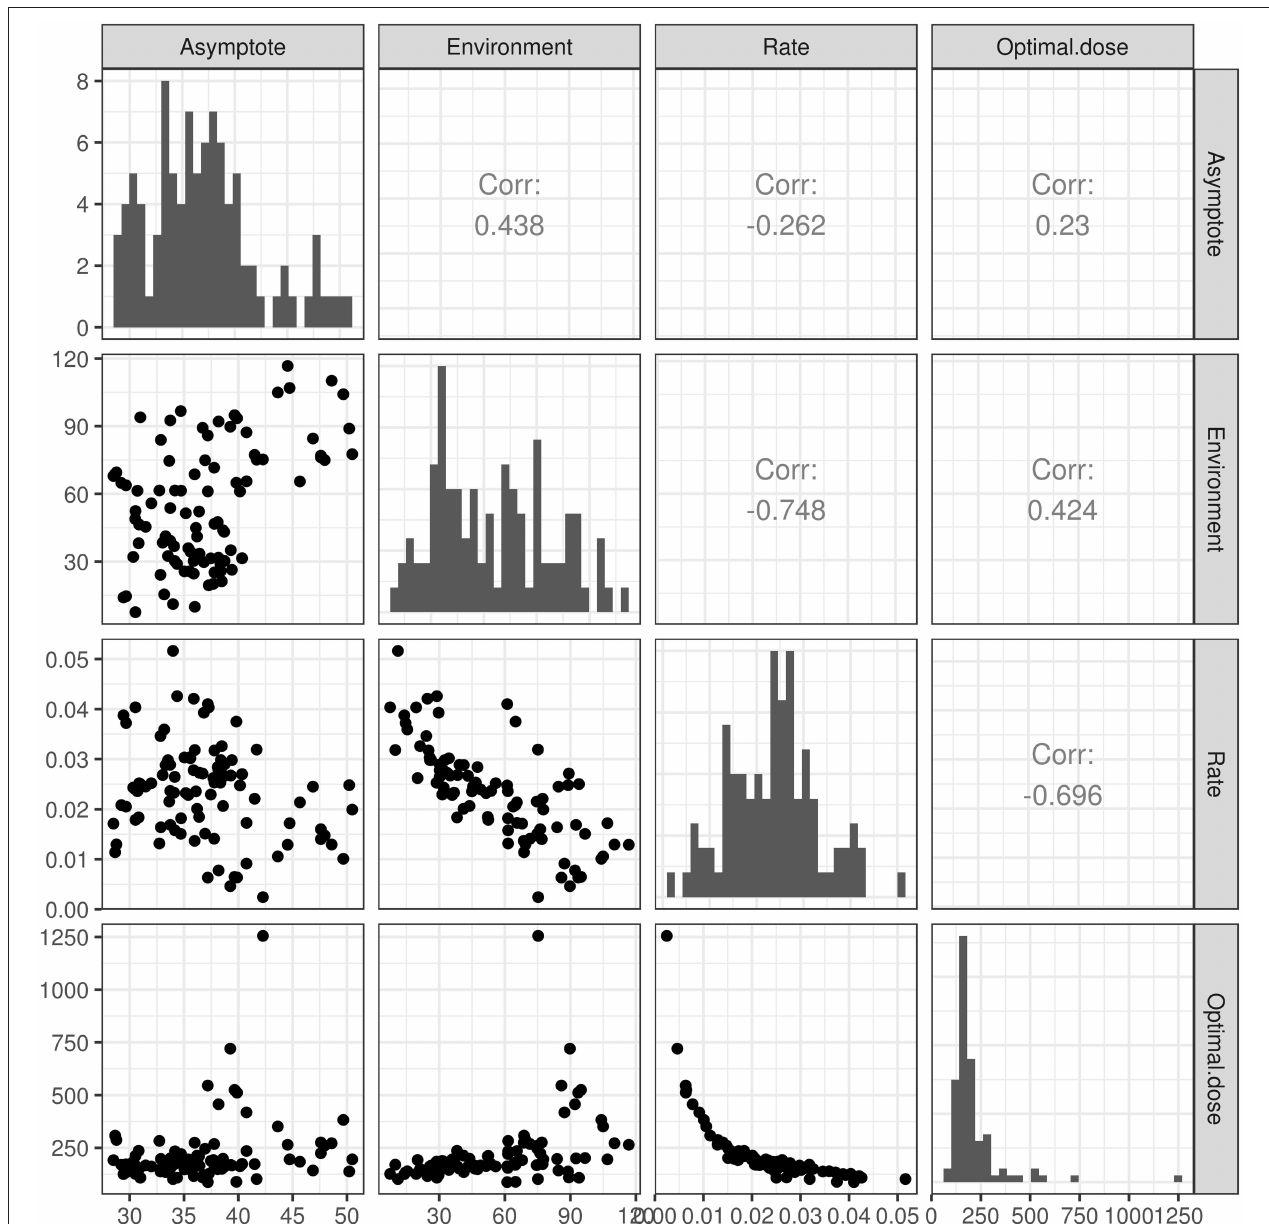
FIGURE 5 | Pairs plot of Mitscherlich parameters and the optimal economical dose obtained with the potato data set. Lower: paired points. Diagonal: distribution histograms. Upper: Pearson